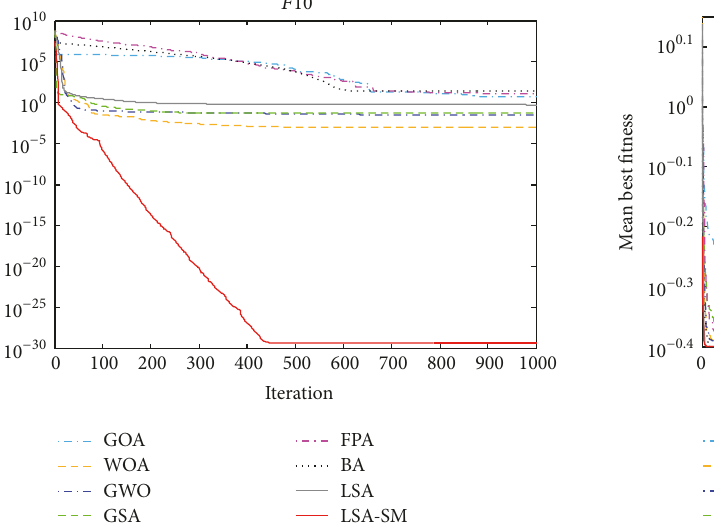
Figure 14: 𝐷 = 30 , convergence curves for 𝑓 10 .